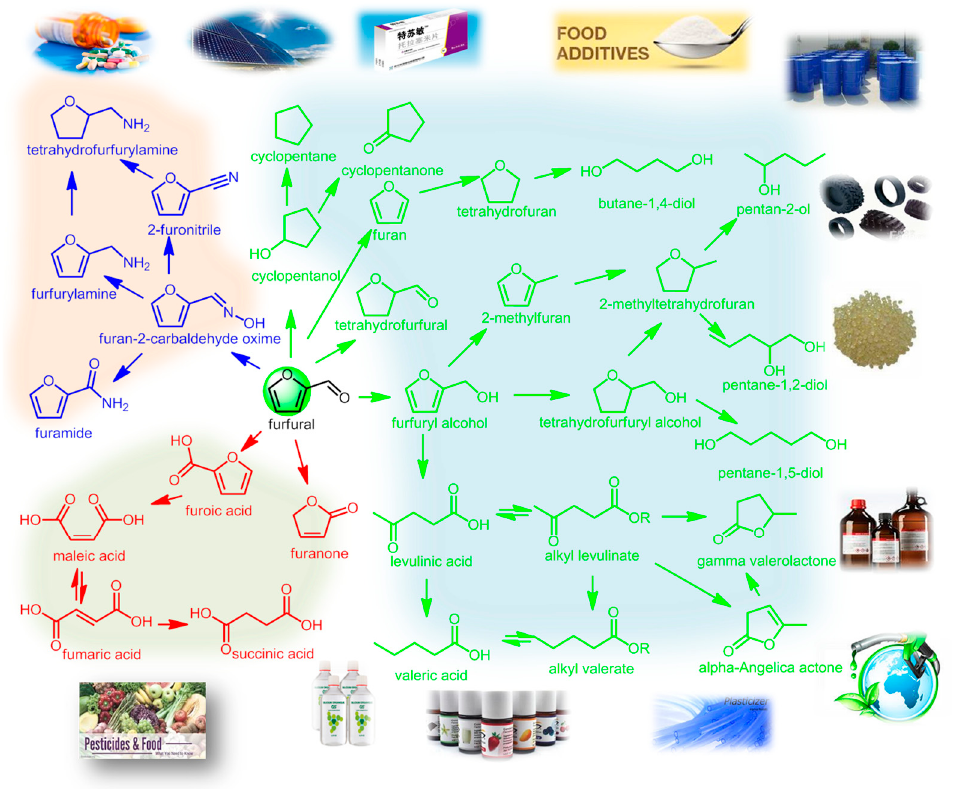
Figure 1. Downstream products of furfural, obtained by hydrogenation (in green), oxidation (in red), cyanation, and other processes (in blue).